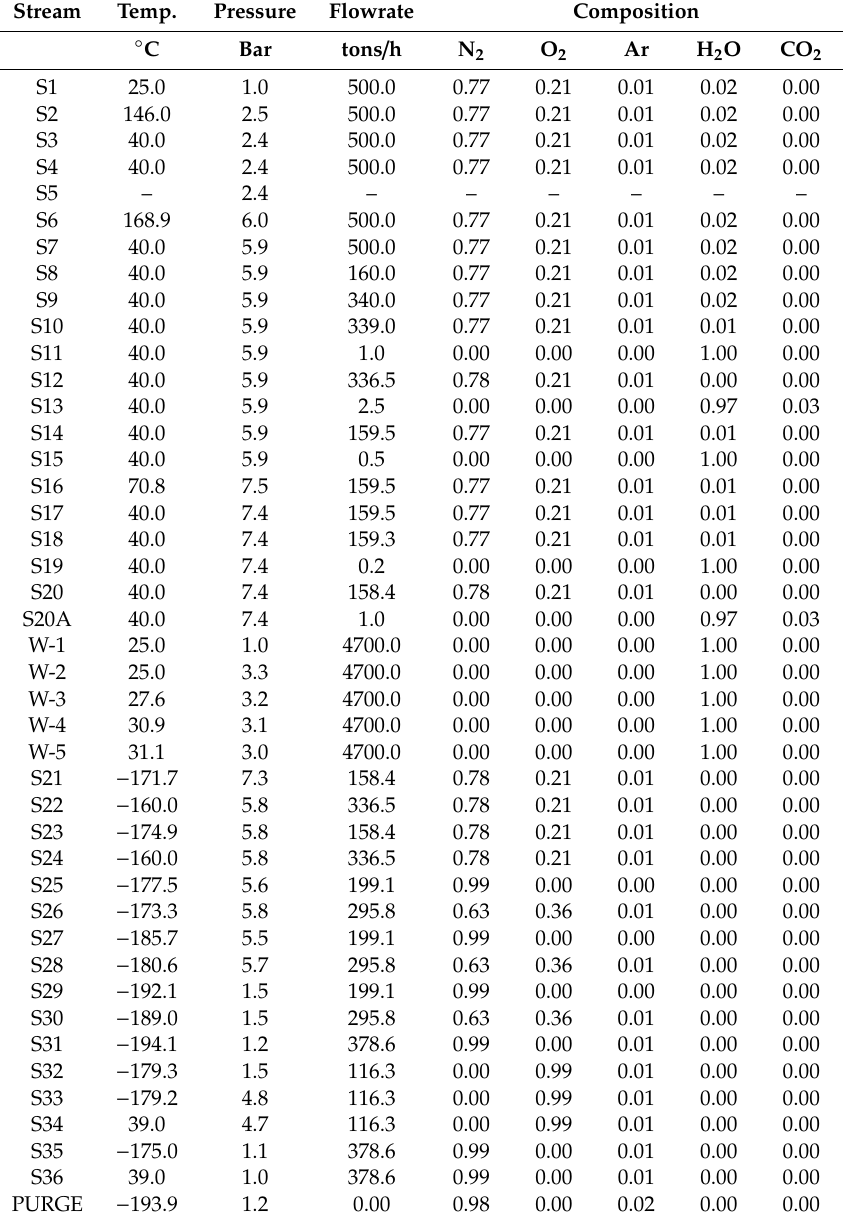
Table 1. Steady-state simulation results for the ASU configuration